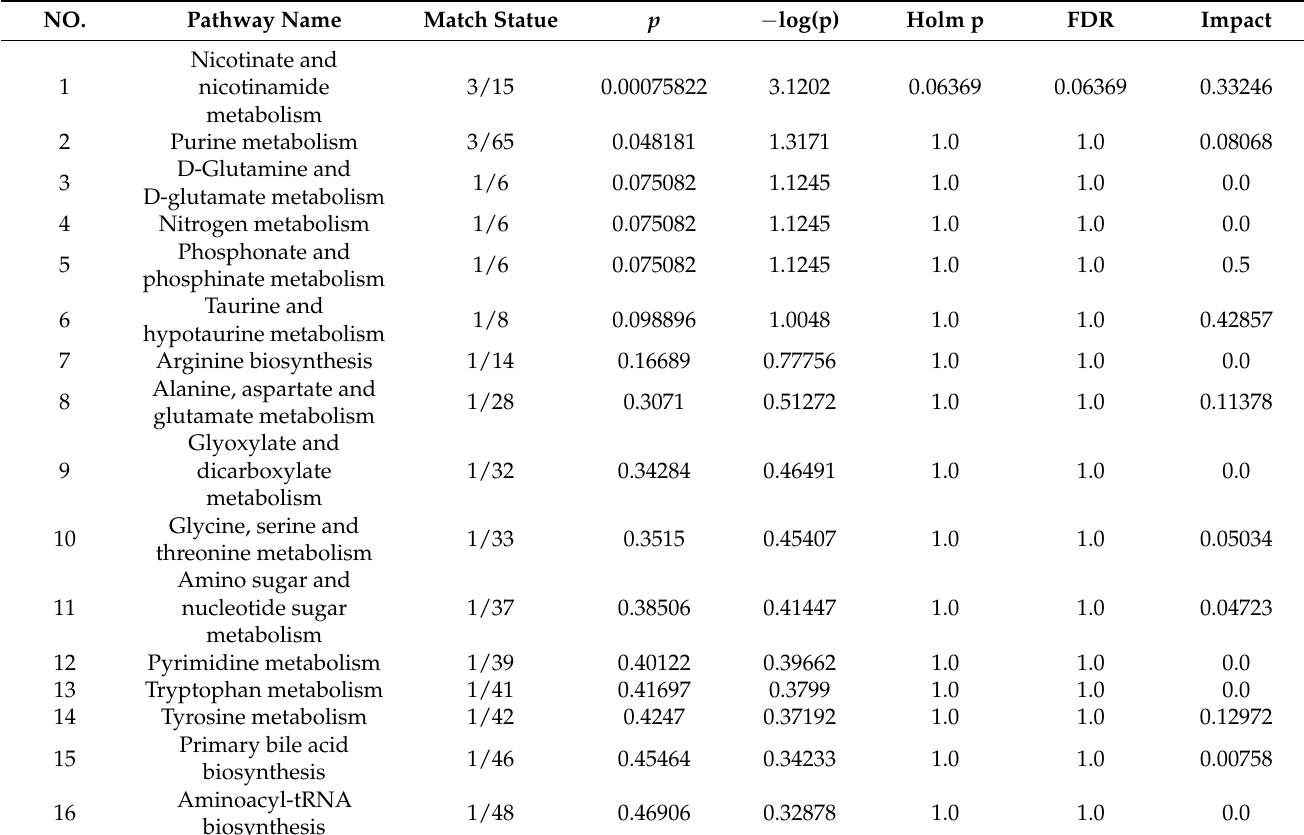
Table 4. MetPA analysis of metabolic pathways for pre-training and post-competition differential metabolites.